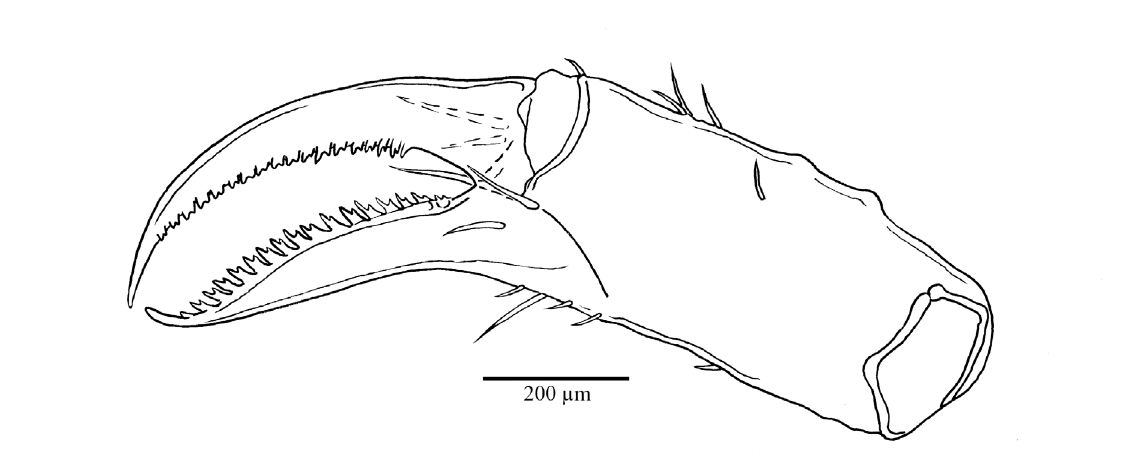
Fig. 13. Nymphon ludovici sp. nov., paratype, ♀, MNHN-IU-2017-219. C